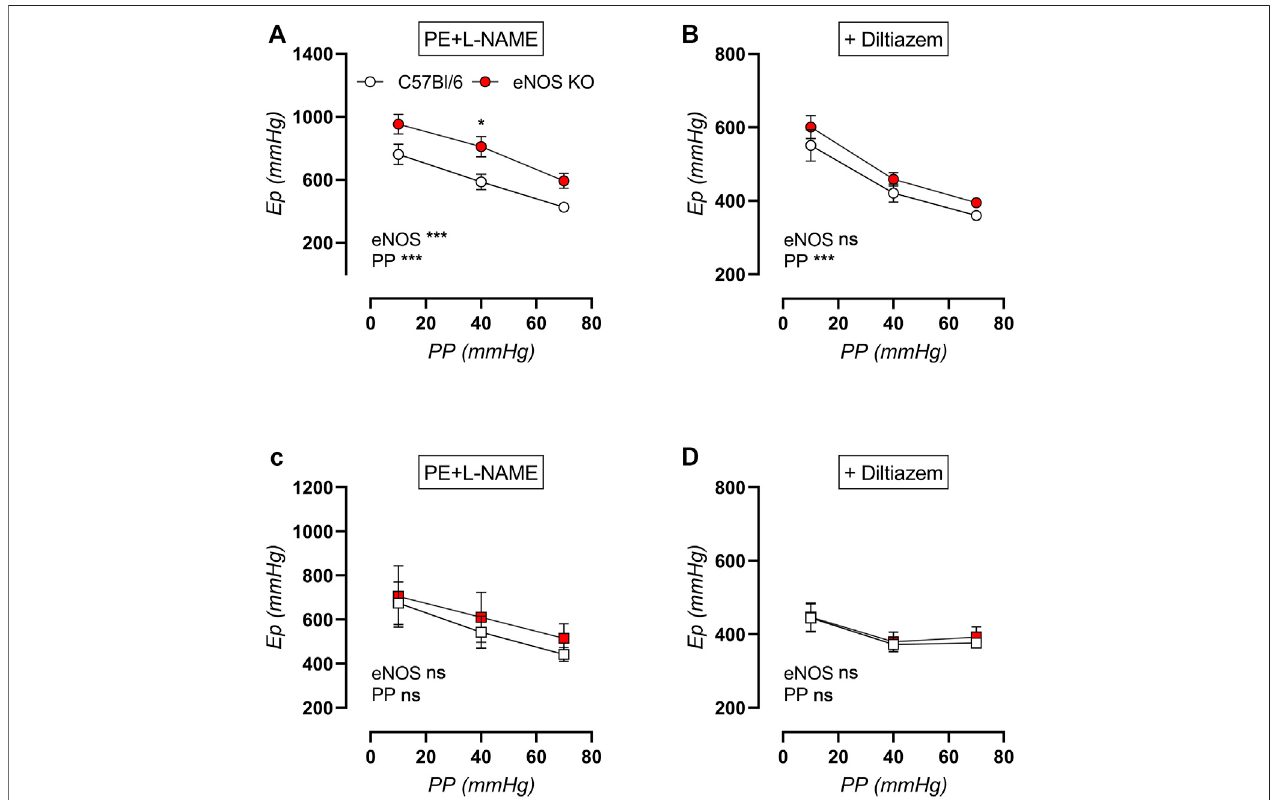
FIGURE13 | Cyclic stretch-dependency ofactive aortic stiffness in2 µM PE-contracted aortic rings. Aortic rings ofyoung (4 months, n = 6) and aged (13 months, n = 4) eNOS knockout and young (4 months, n = 6) and aged (14 months, n = 4) C57Bl/6 control mice were subsequently exposed to 5 min of cyclic stretch at low (10 mmHg), physiological (40 mmHg), and high (70 mmHg) pulse pressure (PP). Active aortic stiffness of young (circles, (A,B) ) and aged (squares, (C,D) ) mice was measured in 2 µM PE-constricted aortic rings in the presence of 300 μ M L -NAME to inhibit basal NO production (A) . Subsequently, 35 µM diltiazem was added to inhibit VGCC-dependent aortic stiffening (B) . Statistical analysis was preformed using two-way ANOVA. Overall (bottom) and post-hoc (in graph) signi fi cance are listed. ns, p > 0.05; *, p < 0.05; ***, p < 0.001.